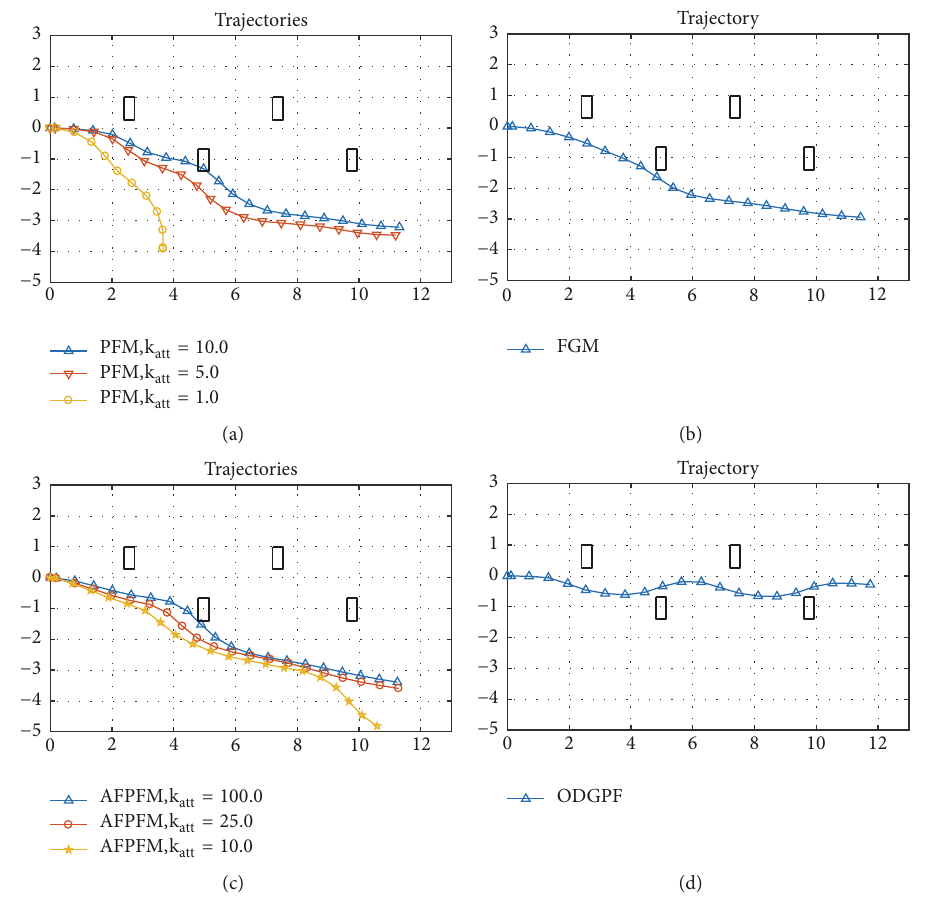
Figure 17: Trajectories of the vehicle with (a) PFM, (b) FGM, (c) AFPFM, and (d) ODG-PF.